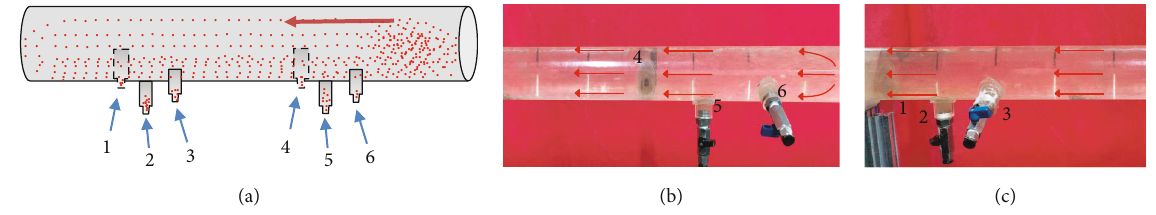
Figure 4: Migration trajectory in the wellbore of 1mm temporary plugging agent. (a) Schematic diagram of the particle migration. (b) Particle migration trajectory at C1. (c) Particle migration trajectory at C2.